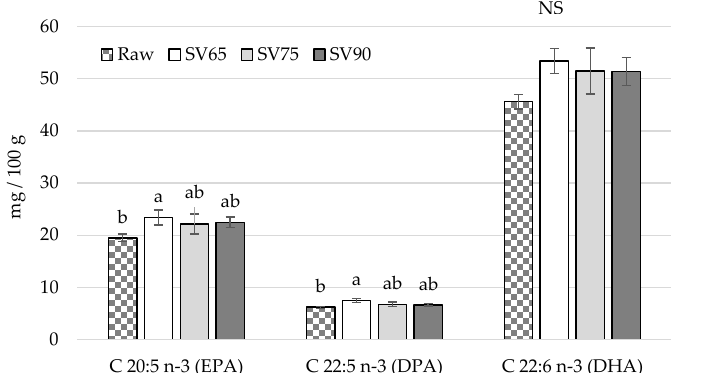
Figure 2. Comparison of fatty acids contents (mg/100 g) in pikeperch fillets: raw and after sous vide treatment proceeded at 65 °C for 45 min (SV65), 75 °C for 20 min (SV75), and 90 °C for 10 min (SV90); vertical bars refer to standard error of the mean; a,b — values denoted with different letters differ significantly at p < 0.05; SFA — saturated fatty acids; MUFA — monounsaturated fatty acids; PUFA — polyunsaturated fatty acids.